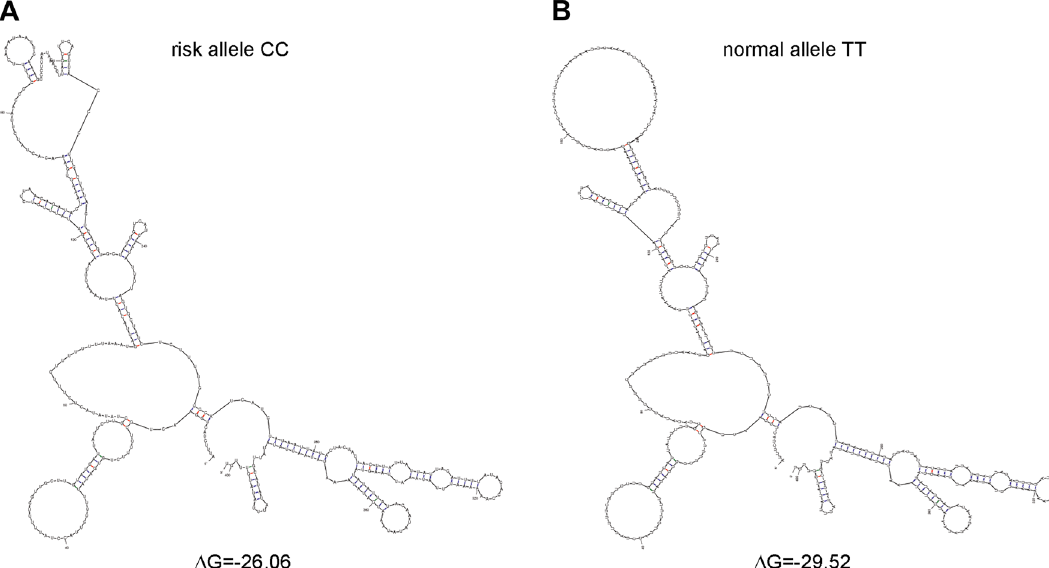
Figure 8. Alteration of computationally predicted RNA secondary structure of the region surrounding rs13126673. The RNA secondary structures in the region at rs13126673 were showed for the ( A ) risk allele CC and ( B ) normal allele TT which were predicted by